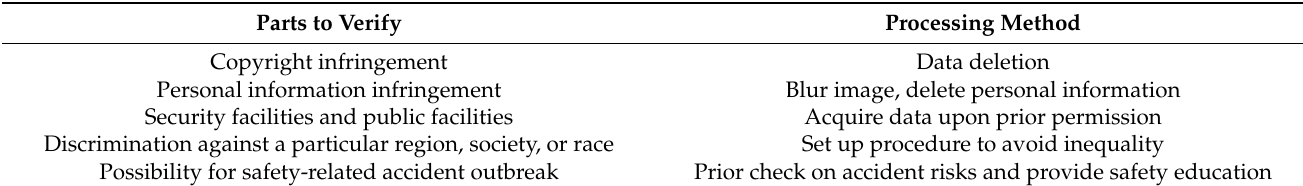
Table 2. Parts to be considered for verification in data acquisition and cleansing.